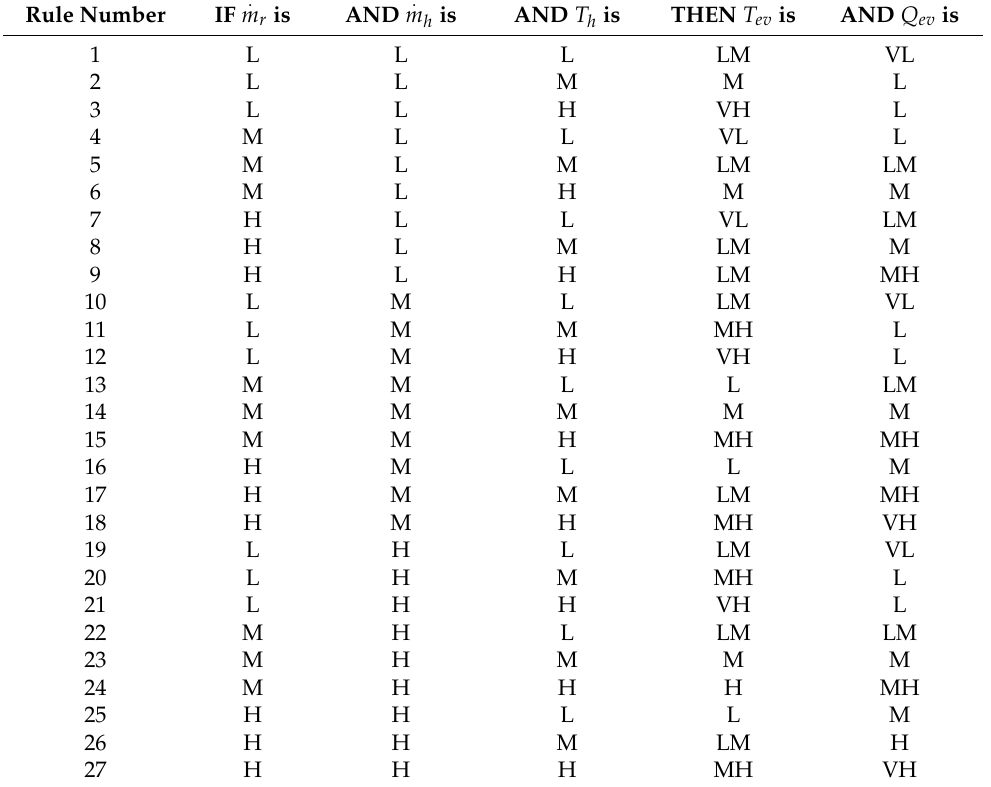
Table 5. Fuzzy rules for the three inputs and two outputs evaporator